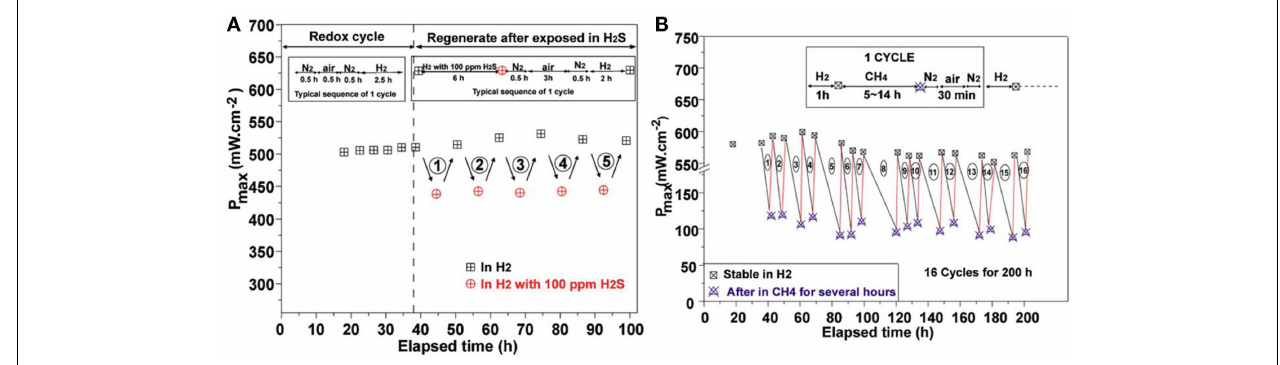
100ppm H 2 S.The maximum power density was recorded after each cycle, (B) the maximum power density of the cell when the anode gas was switched between H 2 , air, and CH 4 for 16 cycles (Liu et al., 2011). Reprinted with permission from